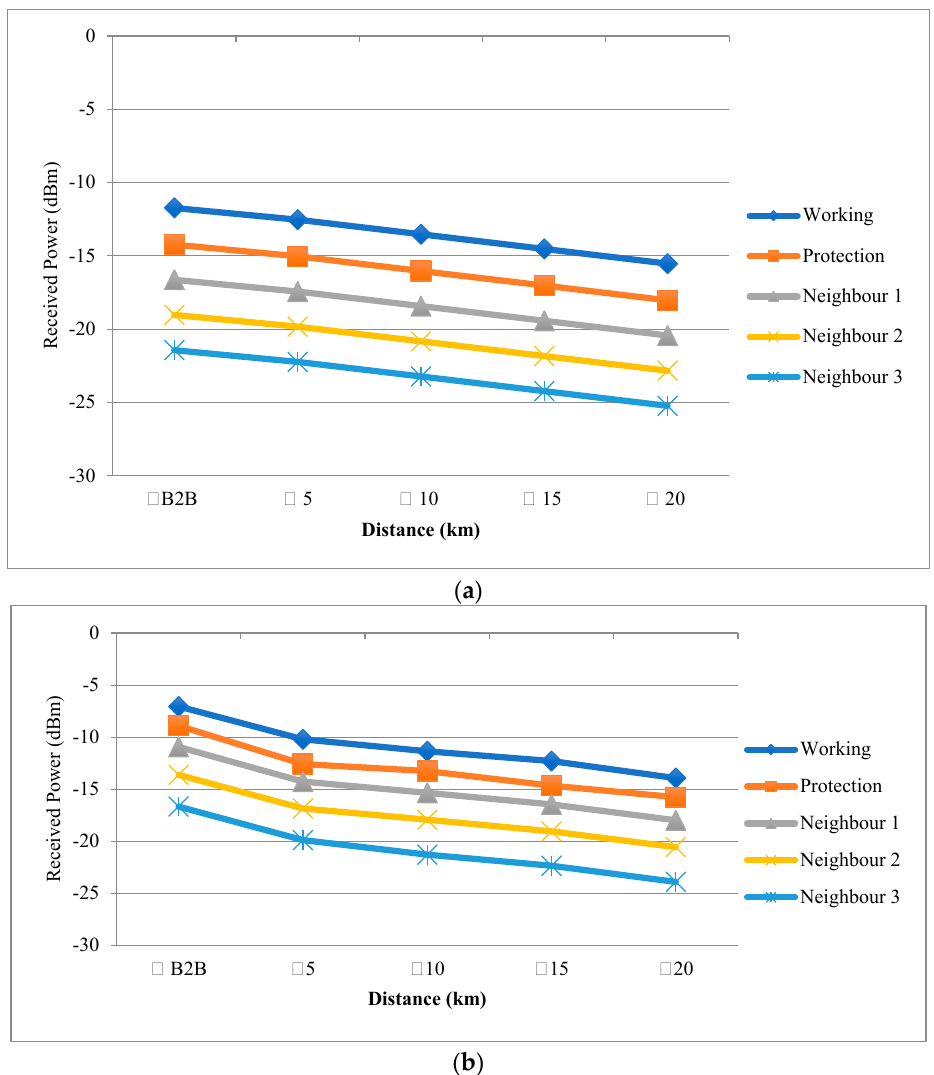
Figure 23. Received power recorded with the ‘zig-zag’ configuration by varying the feeder distance: ( a ) simulation, ( b ) experiment.